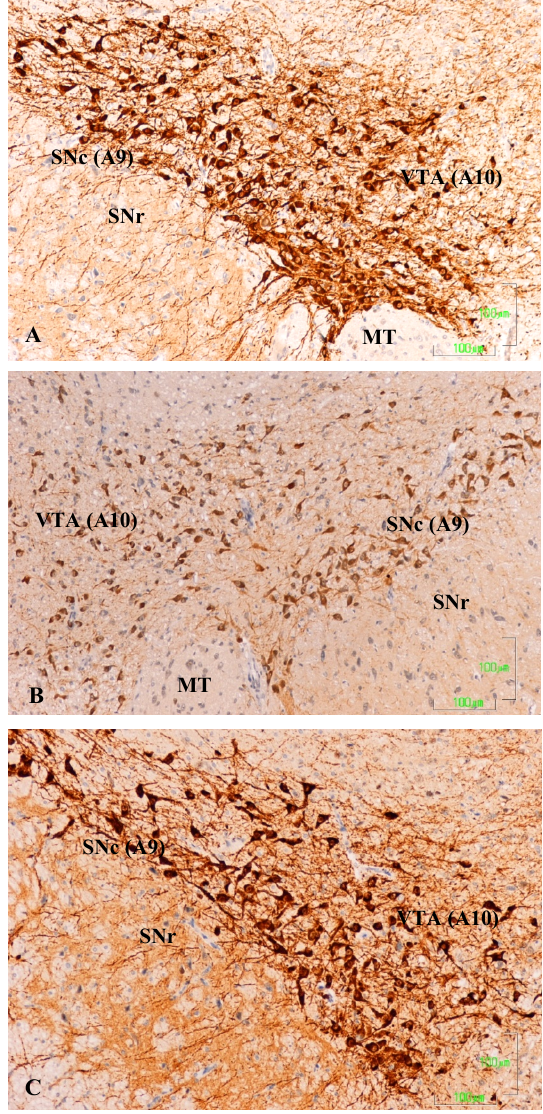
Figure 1. ( A – C ). Tyrosine hydroxylase immunoreactivity in the meso-diencephalic dopaminergic system of rats from the control ( A ), paroxetine ( B ), and agomelatine ( C ) groups. Bars, 100 m. SNc, substantia nigra pars compacta; SNr, substantia nigra pars reticulate; VTA, ventral tegmental area; MT, mammilothalamic